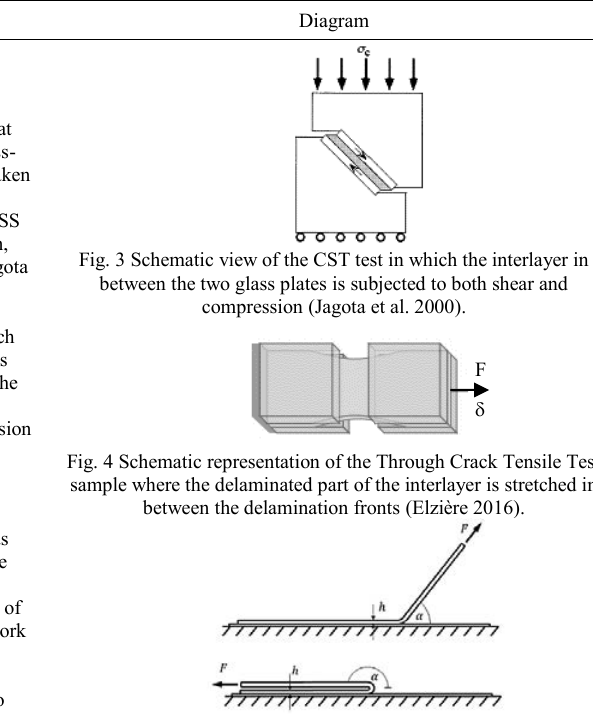
Fig. 5 Configurations of the peel test for different peel angles, a (Eitner and Rendler 2014; Kinloch and Williams 2002).